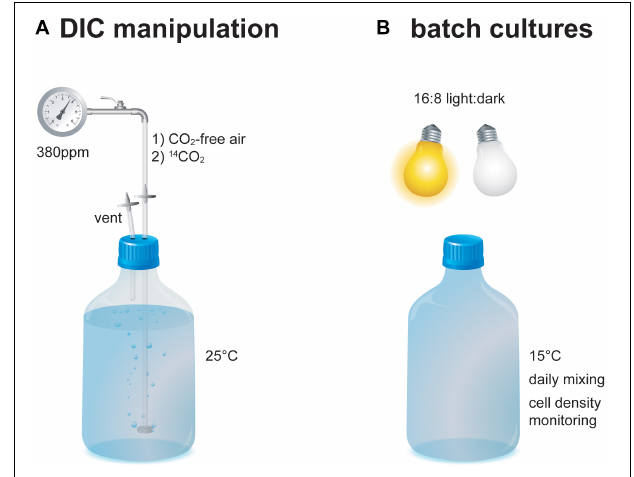
FIGURE 1 | Schematic of the experimental setup during (A) DIC 14 C manipulation and (B) batch culture growth of the E. huxleyi and T. pseudonana